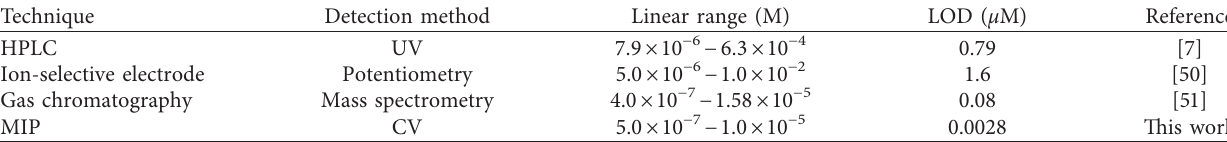
Table 6: Comparison of the results of different techniques on determination of MEL. Technique Detection